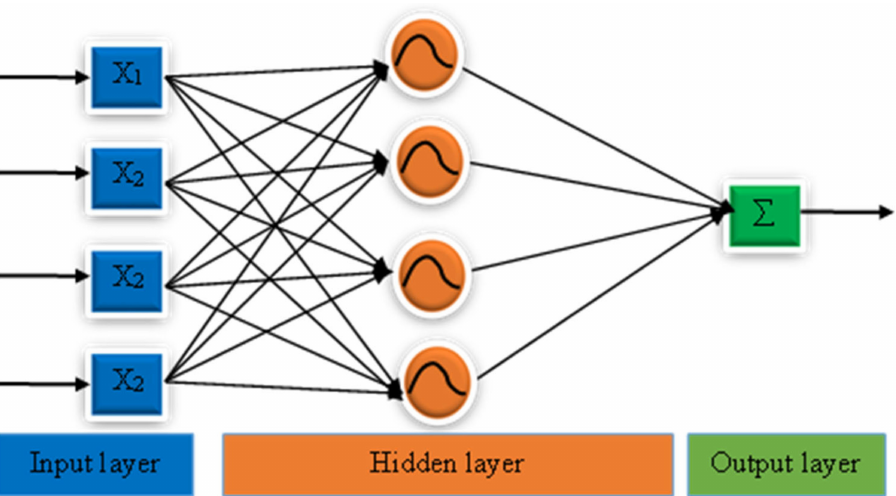
Figure 2. The architecture of a multilayer perceptron and radial basis function neural